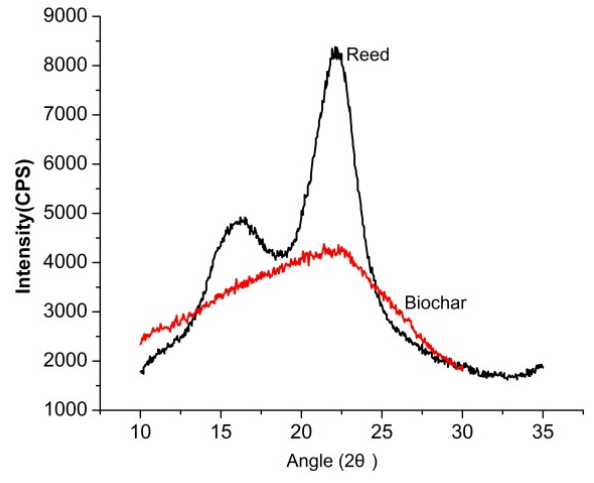
Figure 4. X ‐ ray Diffraction ( XRD) results for reed and biochar obtained at 280 °C, 4.0 h.